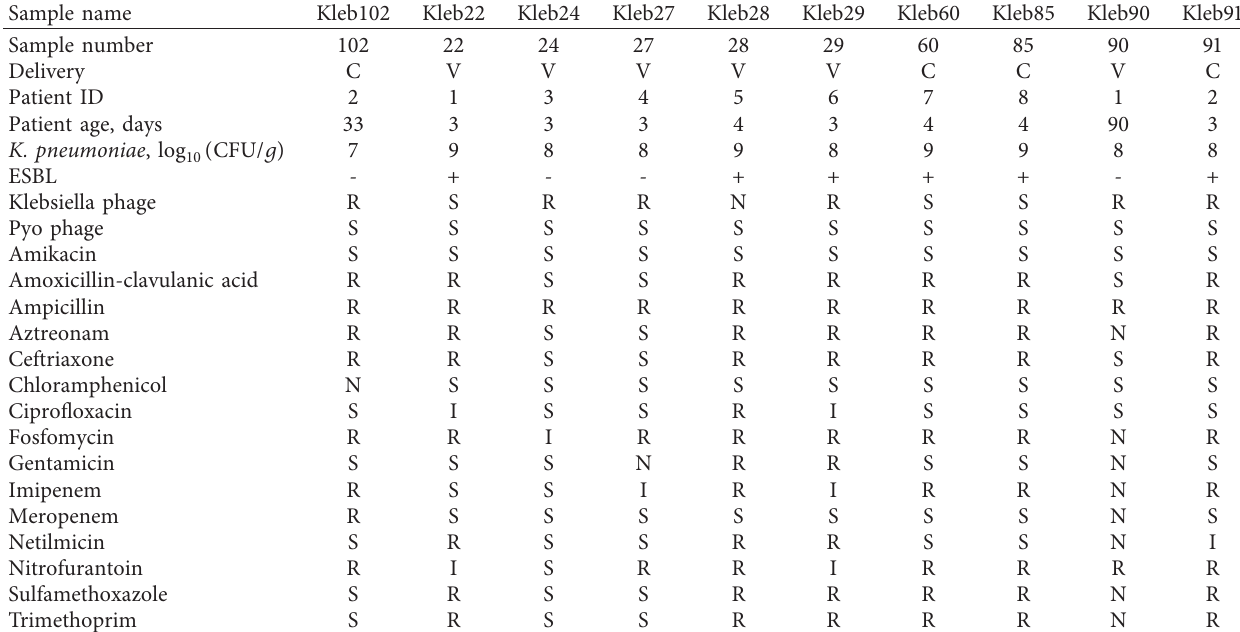
Table 1: Patient data, sample data, and demonstrated drug resistance of the studied K. pneumoniae isolates. Sample